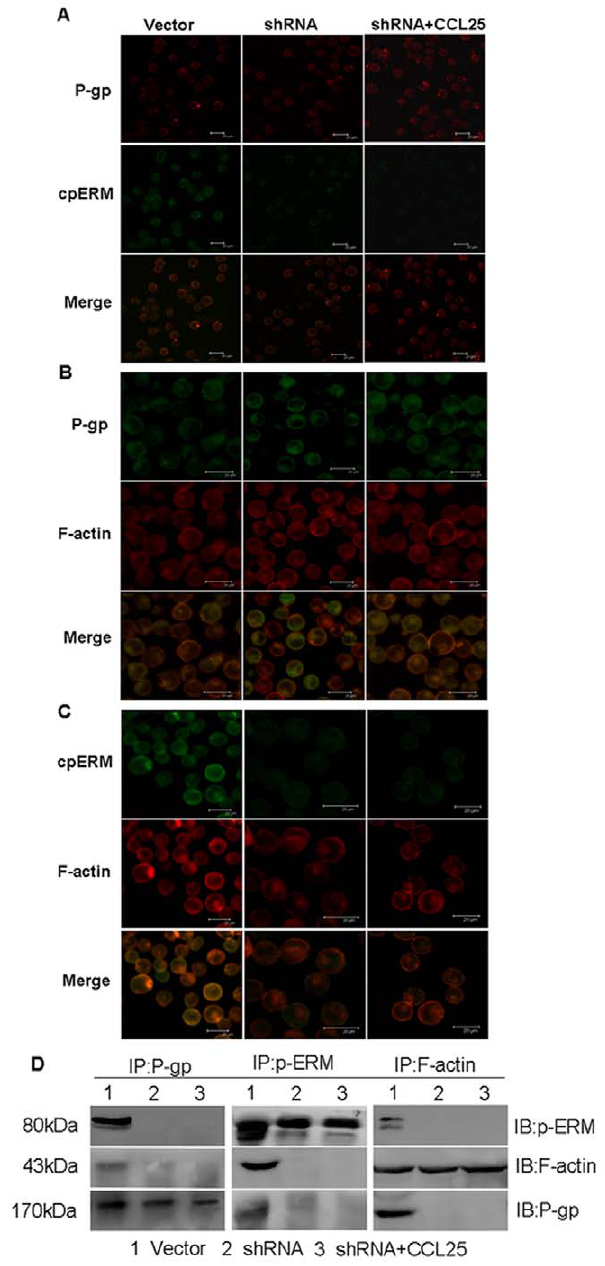
Figure 8. Role of P-gp-p-ERM-F-actin association in ERM- silenced MOLT4 cells treated by CCL25. Shown are the subcellular localizations of (A) P-gp (red) and p-ERM (green), (B) P-gp (green) and F- actin (red), (C) p-ERM (green) and F-actin (red) in ERM-silenced MOLT4 cells treated by CCL25. All images showed P-gp and p-ERM or F-actin distribution on the cells. Bar=20 m m. (D) Co-immunoprecipitation analysis of ERM-silenced MOLT4 cells, either untreated or pretreated with